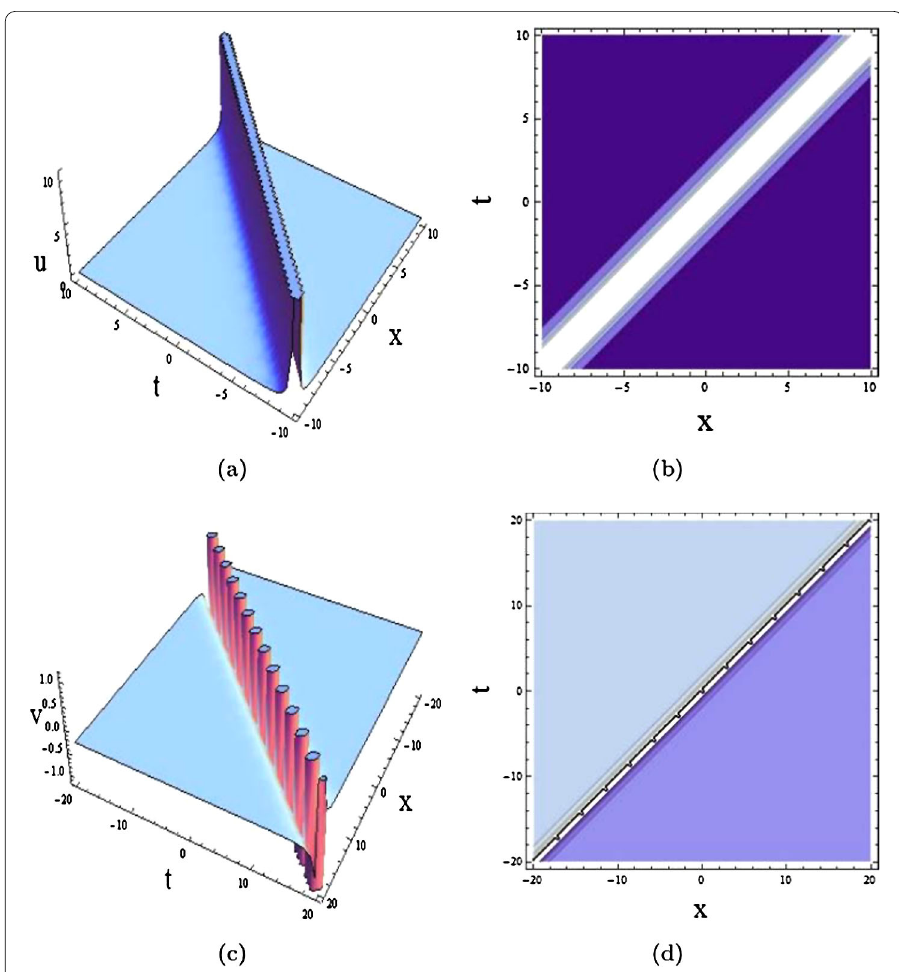
Figure 1 Plot of explicit solution (30) with a = b = c = d = k = 1, C = 0. (a) Perspective view of the solution u ( x , t ). (b) Overhead view of the solution u ( x , t ). (c) Perspective view of the solution v ( x , t ). (d) Overhead view of the solution v ( x , t